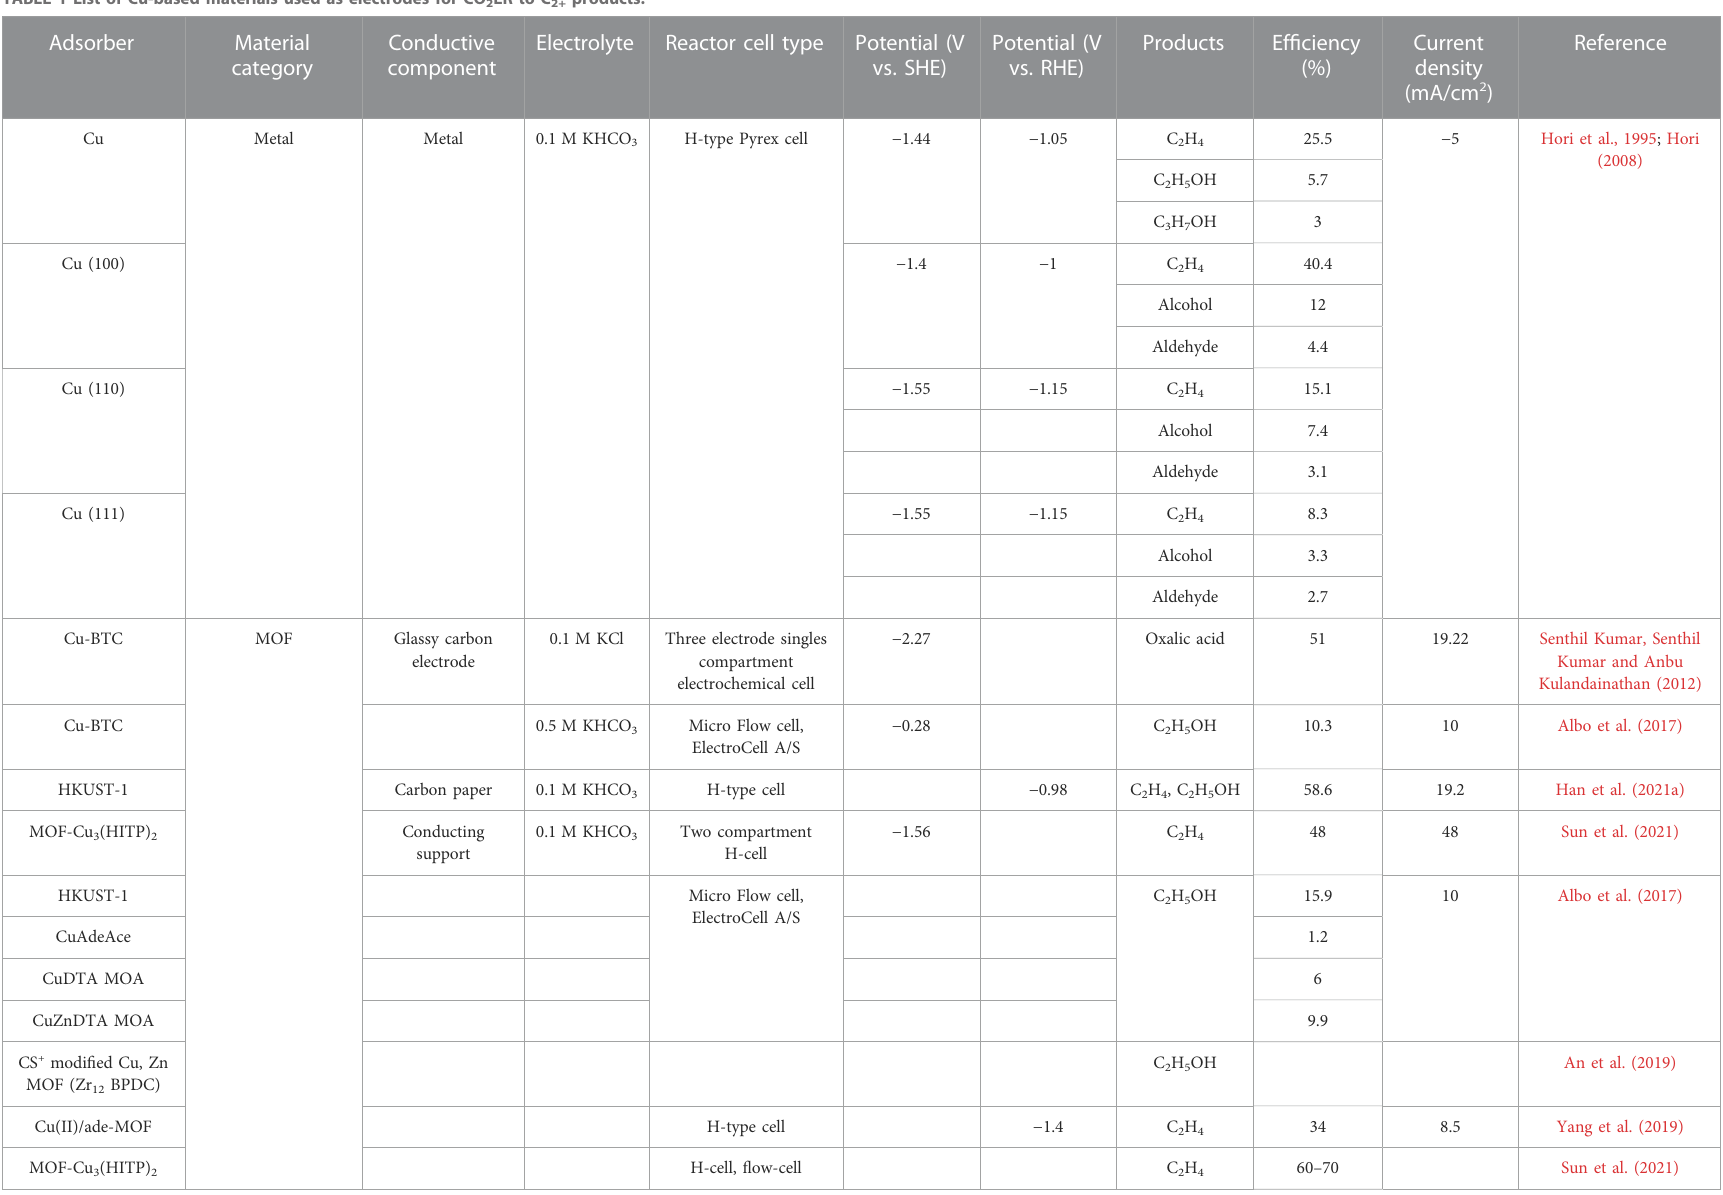
TABLE 1 List of Cu-based materials used as electrodes for CO 2 ER to C 2+